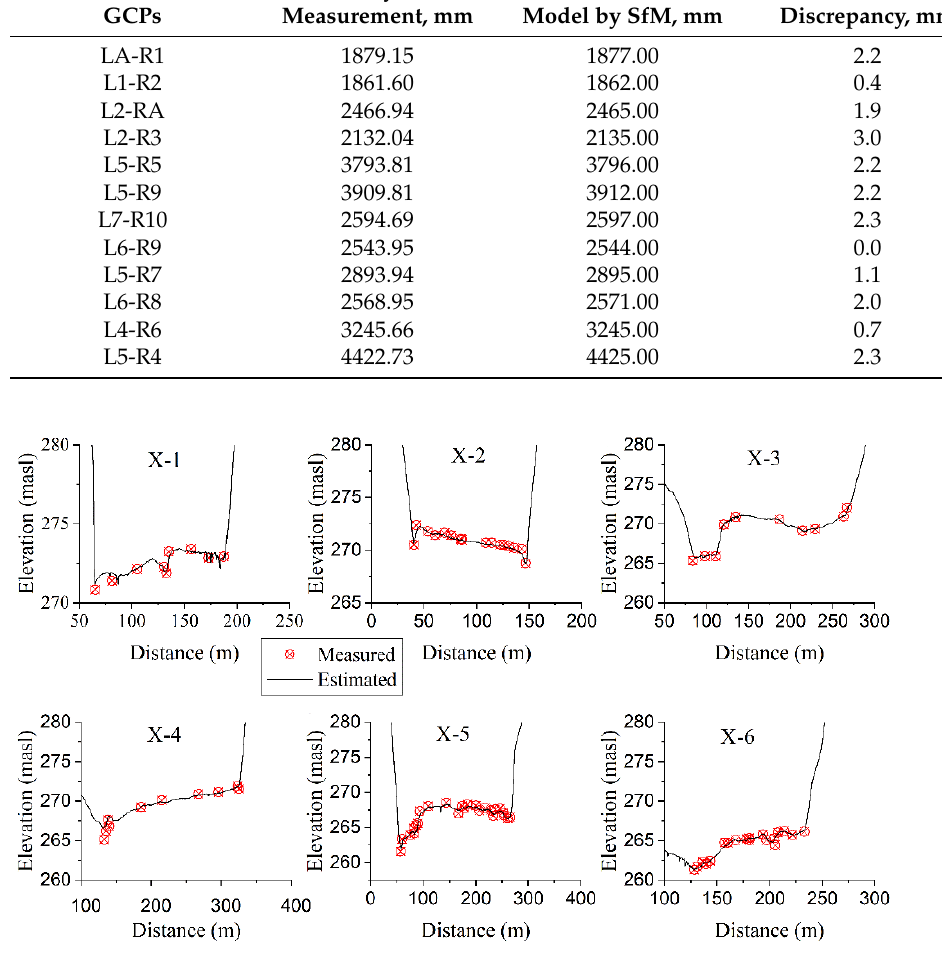
Figure 4. Plots of cross-sections estimated by SfM and manually measured cross-sections upscaled to prototype scale. prototype